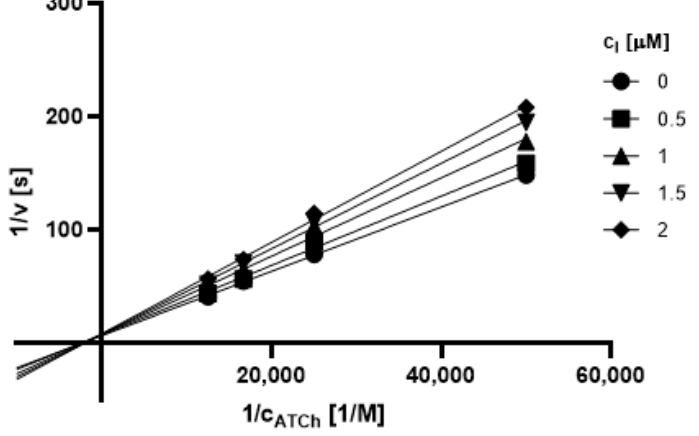
Figure 13. Lineweaver–Burk plot for 2e and AChE inhibition (ATCh = acetylthiocholine).